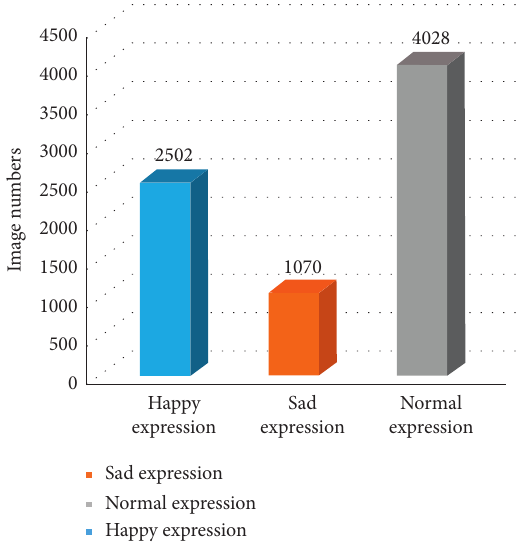
Figure 1: Image numbers of three expressions after